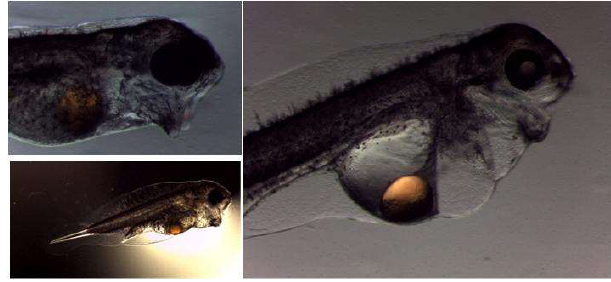
Figure 10. Deformed individuals collected during larval rearing.